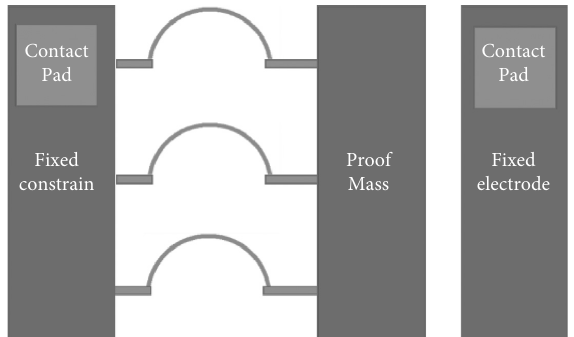
Figure 2: Proposed inertial sensor 2 with three semicircular beams.